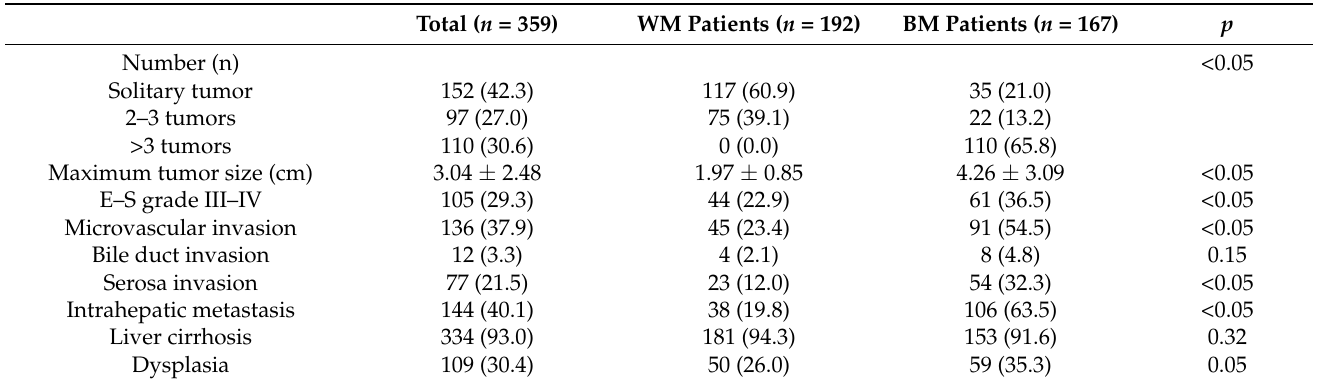
Table 2. Comparison of pathologic findings of HCC in explanted livers according to the Milan criteria assessment. Total ( n = 359) WM Patients ( n = 192) BM Patients ( n = 167)